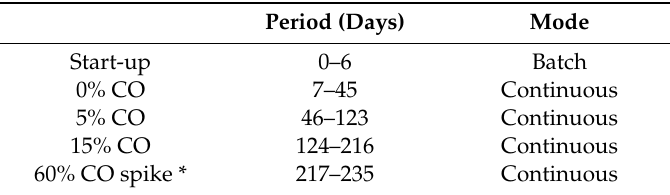
Table 2. Overview of operational characteristics of bioreactor